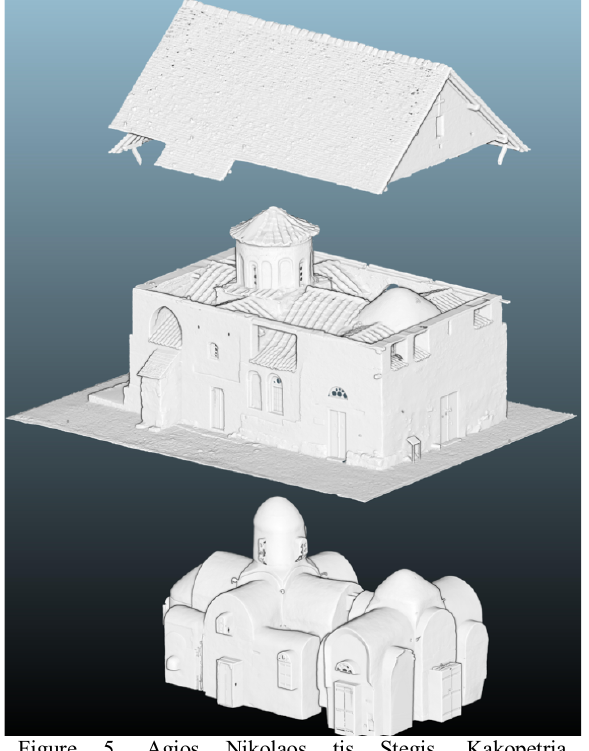
Figure 5. Agios Nikolaos tis Stegis, Kakopetria.